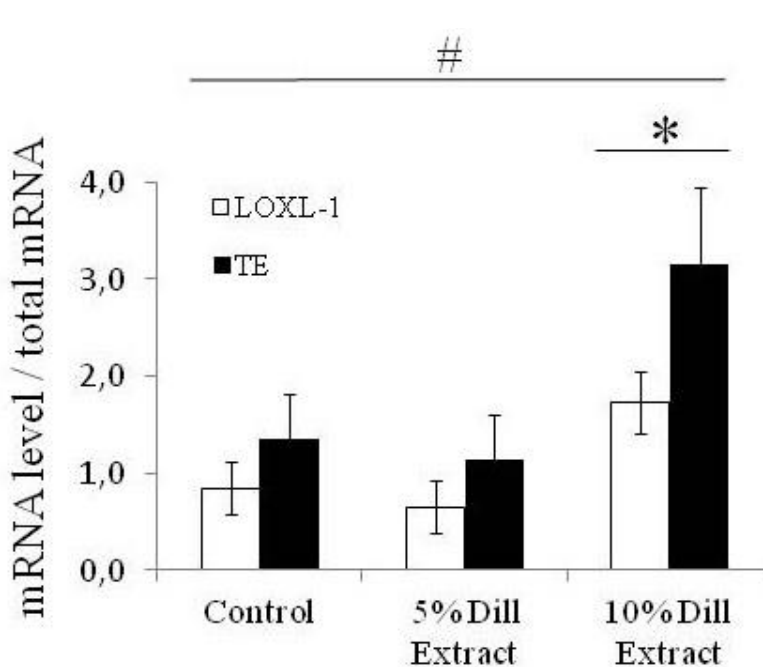
Figure 3. Tropoelastin (TE) and lysyl-oxidase-like-1 (LOXL-1) mRNA levels after DE treatments of aged mice. # Significant effect of treatment (two-way ANOVA, p ≤ 0.05). * Significant difference between 10% DE-treated mice and corresponding untreated (control) 24-month-old mice (LSD test following two-way ANOVA, p ≤ 0.05). n = 3–7 in each group.